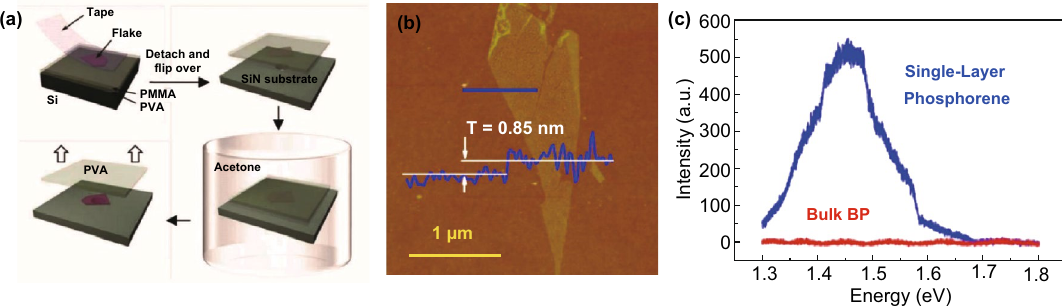
Fig. 1 a The process of preparing phosphorene by mechanical exfoliation method [42]. b AFM image and c PL spectra of monolayer phos- phorene prepared by mechanical exfoliation method [44]. Adapted from Refs. [42, 44] with